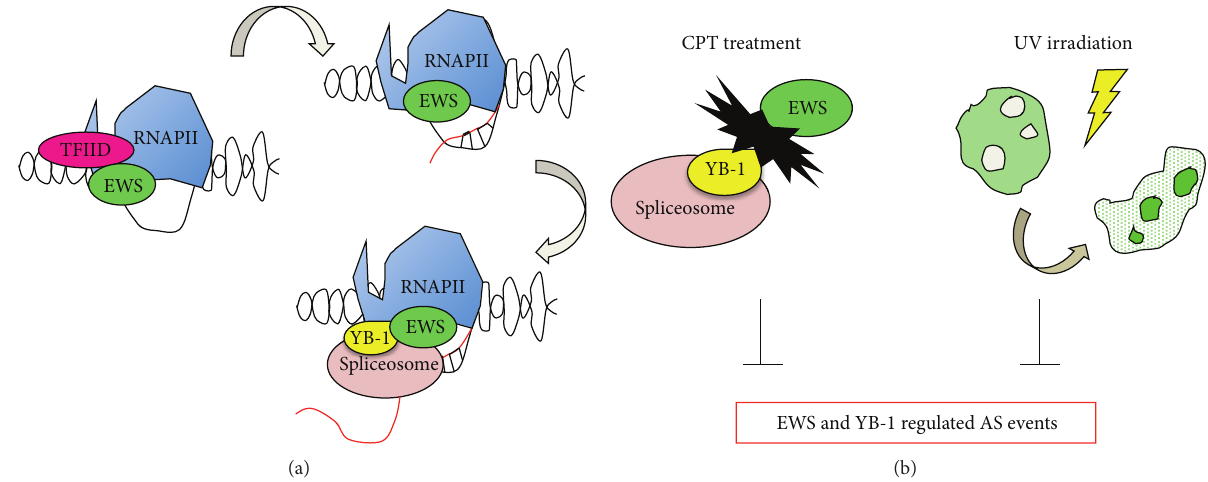
Figure 2: Schematic representation of the cross-talk between the transcriptional and splicing machineries mediated by RNAPII, EWS, and YB-1. (a) In normal condition EWS associates with the preinitiation complex TFIID, with the RNAPII and with its target transcripts and associated genomic regions; once the transcription has started, EWS jumps on the nascent RNA promoting specific AS events. (b) Upon CPT treatment EWS dissociates from YB-1 and from the spliceosome [64]. Similarly, upon low intensity UV light irradiation EWS dissociates from active transcription sites and relocalizes to nucleoli [51]. As a result, EWS regulated AS events cannot occur [51,